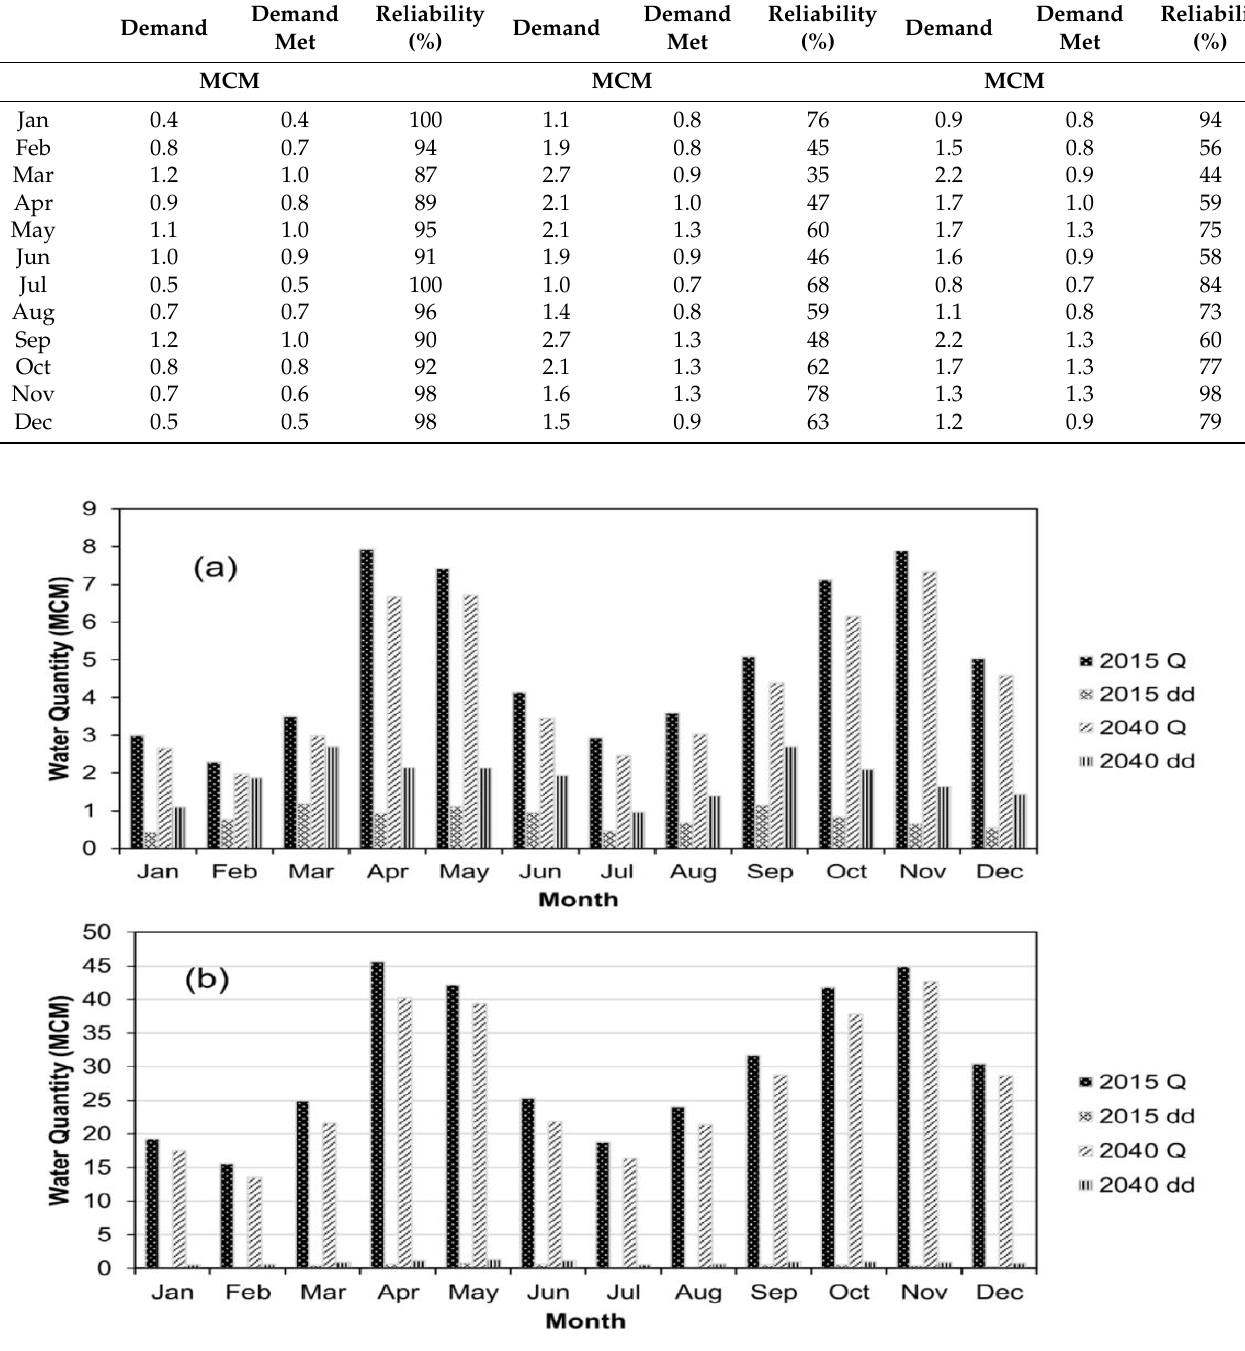
Figure 9. Monthly water demand and availability analysis for Sebwe ( a ) and Mubuku ( b ).